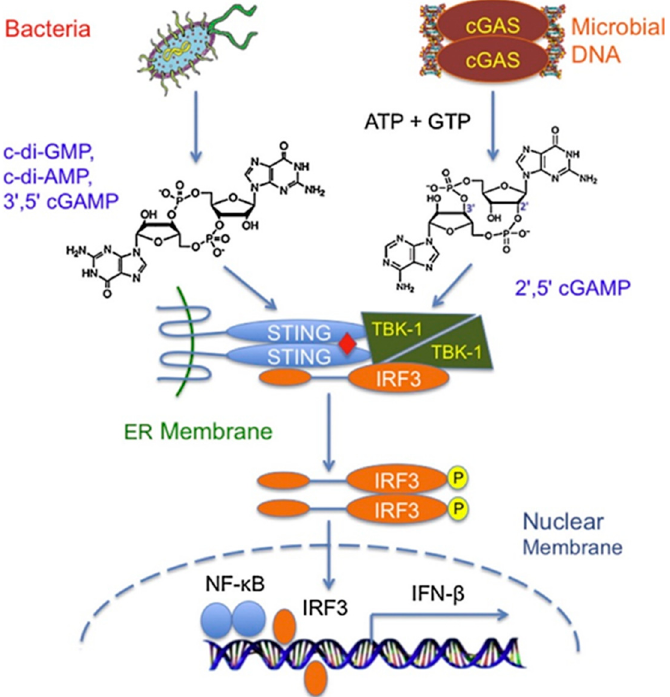
Figure 4. Innate immune sensing of bacterial cyclic dinucleotides and microbial DNA through the cGAS-STING pathway. Reproduced from Figure 1 of the work of [46] with permission from Copy- right Clearance Center, Inc. ER: endoplasmic reticulum; TBK-1: TANK-binding kinase 1; IRF3: in- terferon regulatory factor 3; NF- κ B: nuclear factor kappa B; IFN- β : interferon- β .